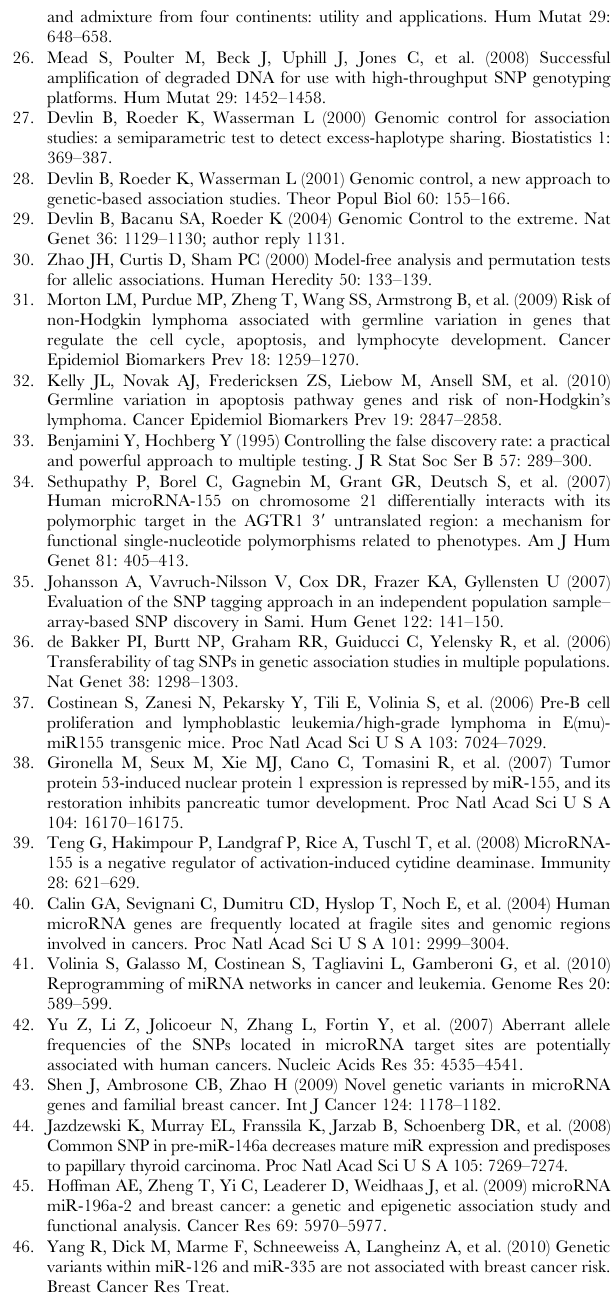
Table S7 Interaction table displaying odds ratios for rs928883 and two AICDA SNPs, rs714629 and rs9971686, derived under an additive